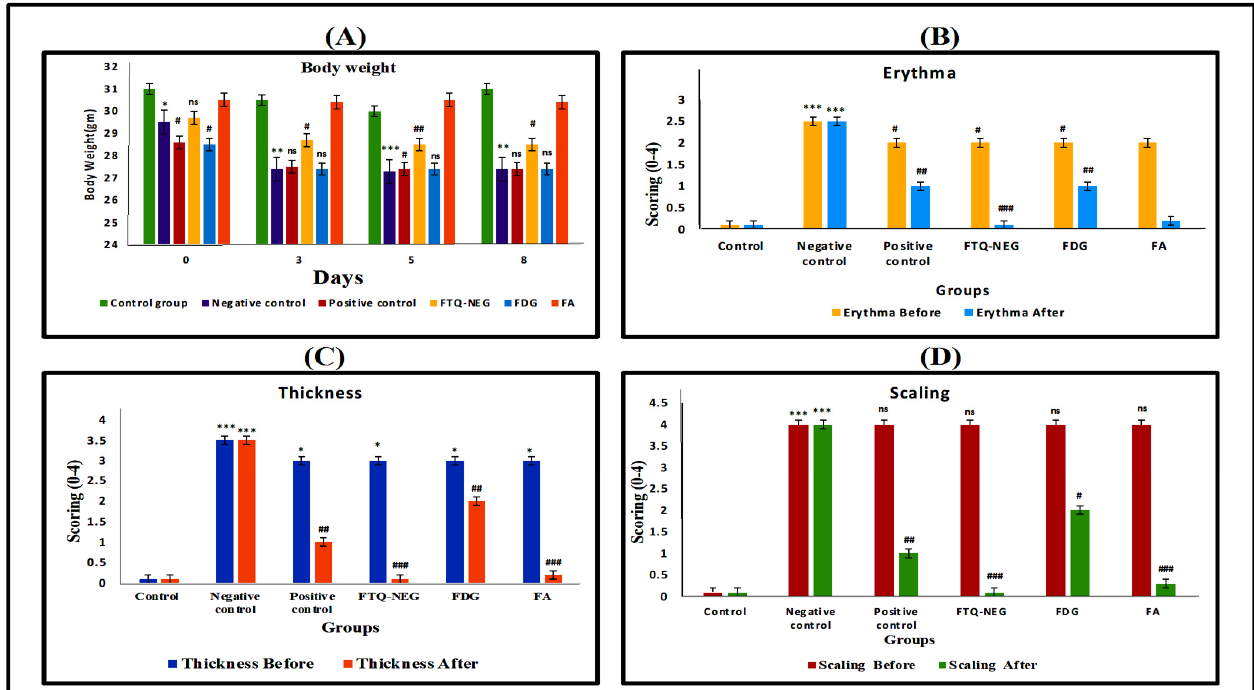
Figure 8. Efficacy study of all the groups. Data are presented as mean ± SD. ( A ) Body weight was decreased in negative control group when compared to control group (* p < 0.05, control vs negative control on 0 th day), (** p < 0.01, control vs negative control on 3 rd day & 8 th day), (*** p < 0.001, on 5 th day) but increased in positive group in comparison to negative control ( # p < 0.05). ( B ) Erythema scoring was significantly increased in negative control group when compared to control group (*** p < 0.001) and decreased in positive control, FTQ-NEG, and FDG groups compare to negative control (( # p < 0.05, ## p < 0.01), ( # ## p < 0.001) in erythema before and after. ( C ) In thickness scoring, negative control group was significantly increased compared to control group (*** p < 0.001) and decreased in positive control, FTQ-NEG, and FDG groups compared to negative control ( ## p < 0.01) in thickness before and after. ( D ) In scaling scoring, the negative control group was significantly increased compared to control group (*** p < 0.001) and decreased in positive control, FTQ-NEG, and FDG groups compared to negative control ( ## p < 0.01) in scaling score after and non-significant in scaling score